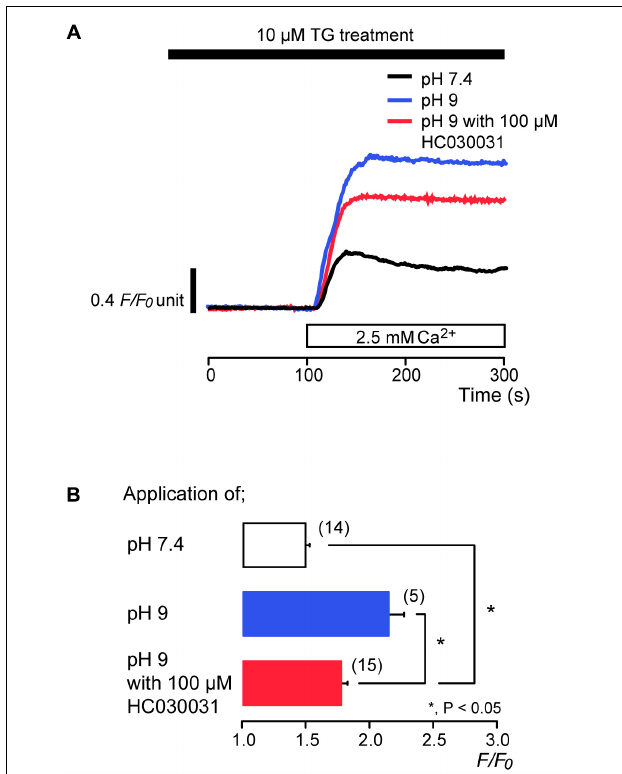
FIGURE 6 | Alkaline stimuli enhance Ca 2 + entry during TG treatment. (A) Representative traces of subsequent application of 2.5 mM extracellular Ca 2 + (white box at bottom) after pre-incubation of 10 µ M TG at pH 7.4 (black line) or at pH 9 without (blue line) or with (red line) 100 µ M HC030031. Black box at the top indicates application of 10 µ M TG. (B) Summary bar graph shows [Ca 2 + ] i increases in response to addition of extracellular Ca 2 + at pH 7.4 (open column) or at pH 9 without (blue column) or with (red column) 100 µ M HC030031. Note that the application time period of TG (A) was longer than that in Figures 1 , 3 – 5 , and thus a peak value of [Ca 2 + ] i for the SOCE at pH 7.4 (black line in A and open column in B ) was larger than that in Figures 1 , 3 – 5 . Each column indicates the mean ± SE of 5–15 independent experiments. Statistically significant differences between columns (shown by solid lines) are denoted by asterisks, ∗ P <